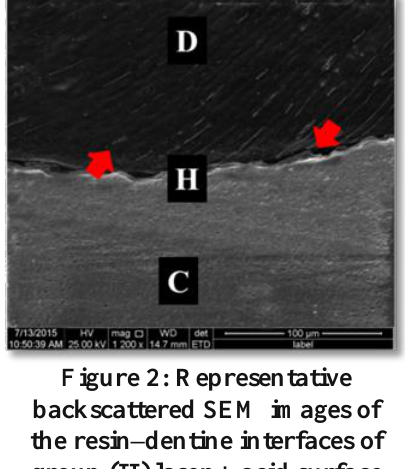
Figure 2: Representative